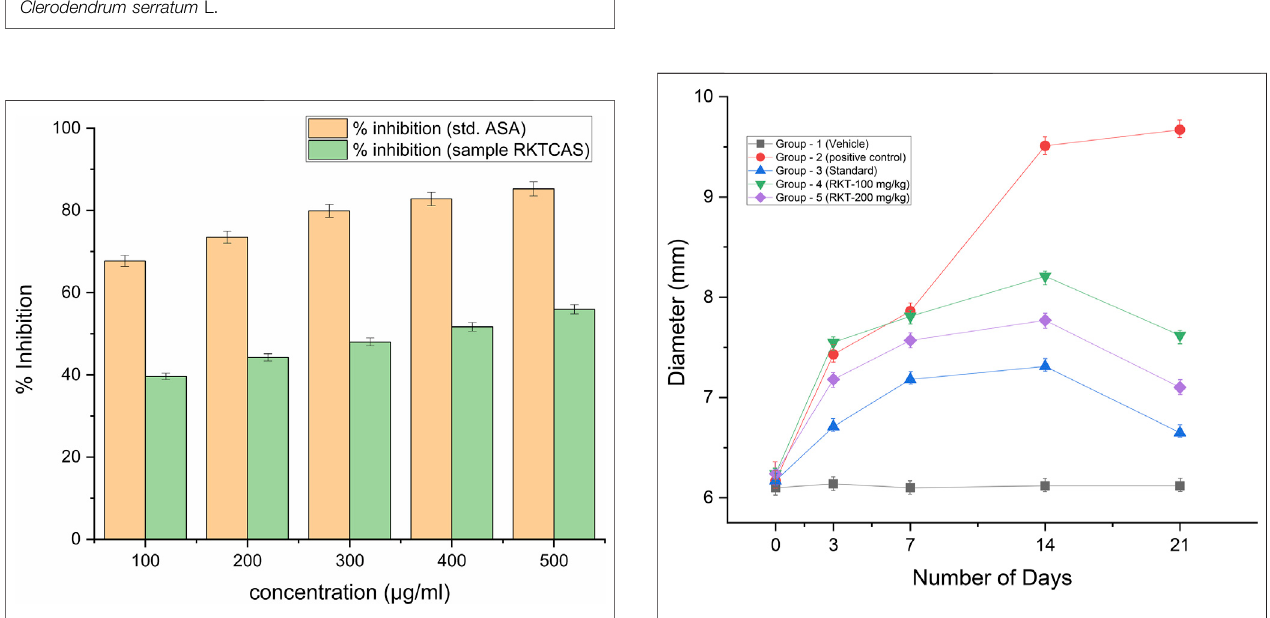
FIGURE 5 | In-vitro protein denaturation activity of aqueous extract of Clerodendrum serratum L. against protein denaturation using egg albumin.